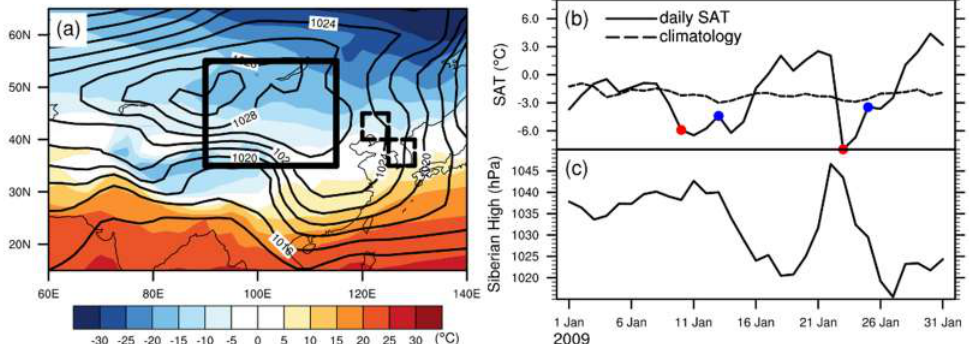
Figure 1. ( a ) The SAT domains of East Asia (two dashed boxes; 35 ◦ N–40 ◦ N, 125 ◦ E–130 ◦ E and 40 ◦ N–45 ◦ N, 120 ◦ E–125 ◦ E) and the domain of the Siberian High (solid box; 35 ◦ N–55 ◦ N, 90 ◦ E–115 ◦ E) used to define cold surges. The climatology of observed mean SLP (contour interval of 2 hPa) and SAT (shading) during the winter season (November to March). ( b ) Times series of daily SAT (solid line) and its climatology (dash line) averaged over 35 ◦ N–40 ◦ N, 125 ◦ E–130 ◦ E during January in 2009. Red (blue) dots indicate the occurrence (termination) date of CSs. ( c ) Time series of daily SLP averaged over the domain of Siberian High during the same period mentioned in Figure 1b.